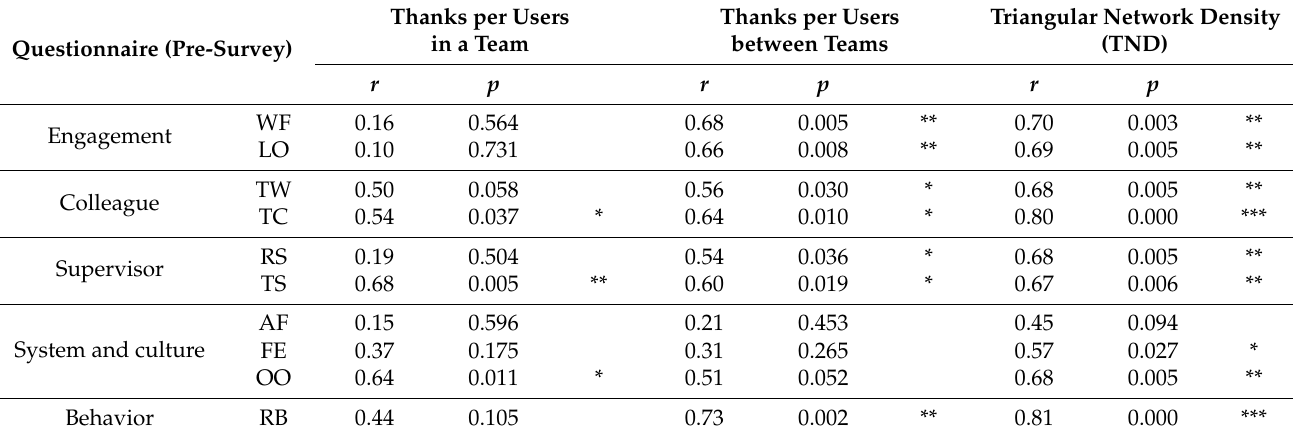
Table 5. Correlations between our 10 engagement factors and the gratitude data from the Thanks